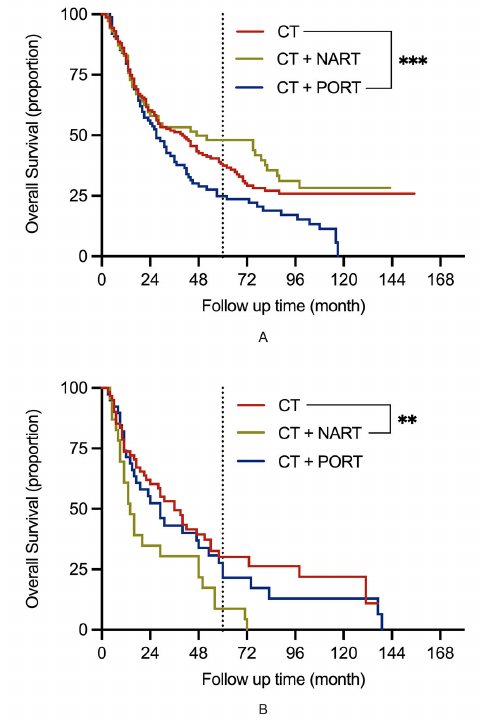
Figure 4. Overall survival in NSCLC patients with N2 stage after propensity score matching. ( A ) in patients below 65 years ( ≤ 65); ( B ) in patients above 65 years (>65). Note: CT, chemotherapy; NSCLC, non ‐ small cell lung cancer; NART, neoadjuvant radiotherapy; PORT, postoperative radiotherapy; ** Indicates significant difference at p < 0.01; *** Indicates significant difference at p < 0.001.